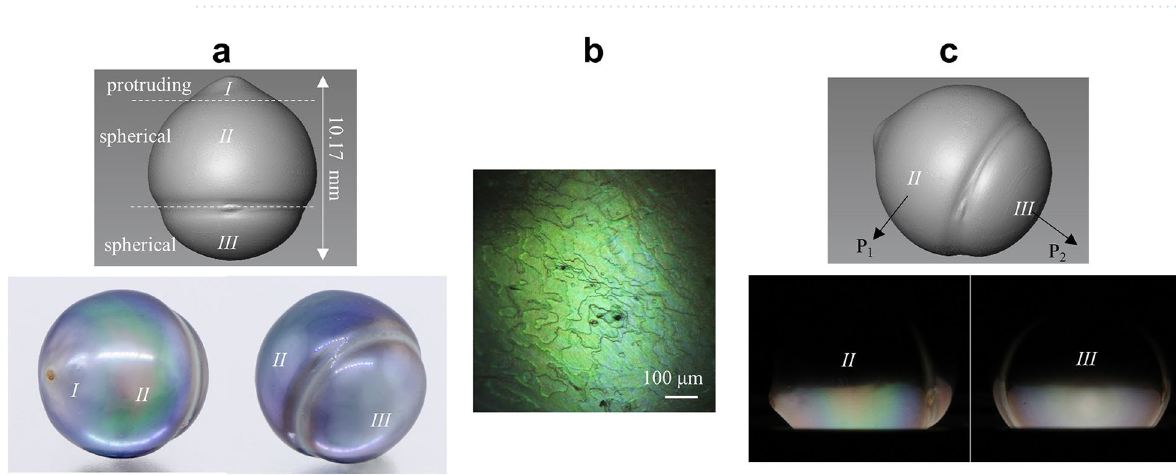
Figure 2. A round Tahitian pearl observed under ( a ) overhead lighting, and ( b ) interference enhanced setup.